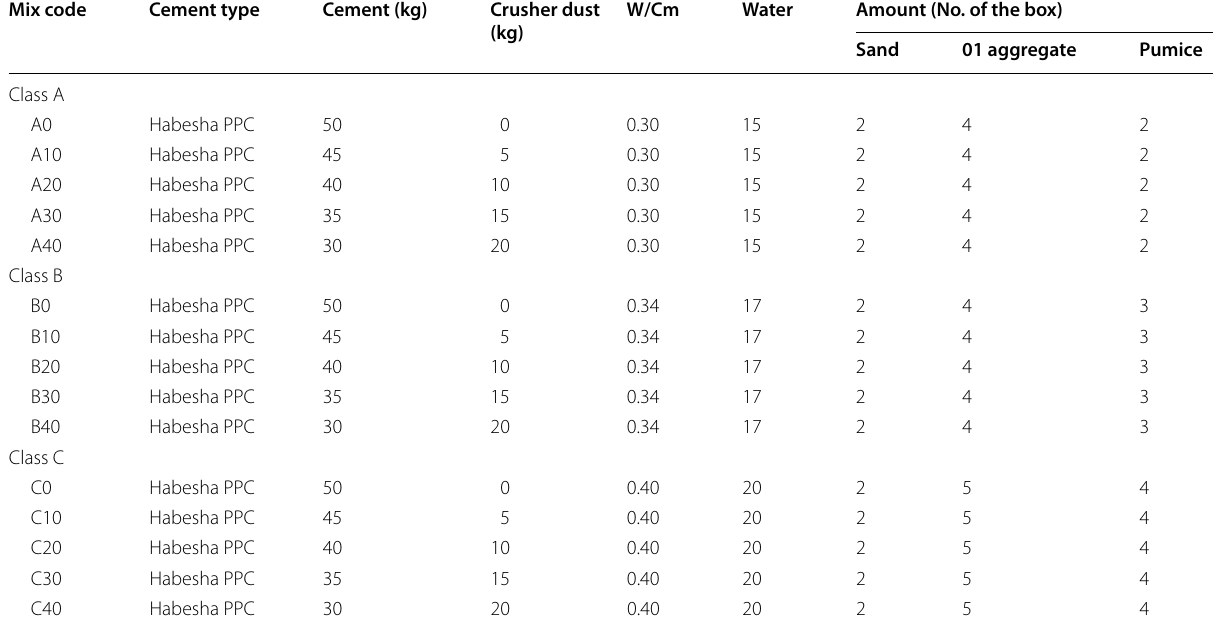
Table 3 Mix proportion for hollow concrete block work.